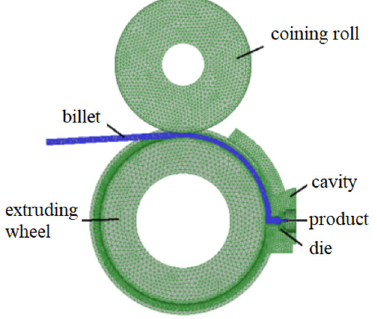
Figure 3. Continuous extrusion schematic diagram. Table 2. Continuous extrusion numerical simulation parameters.